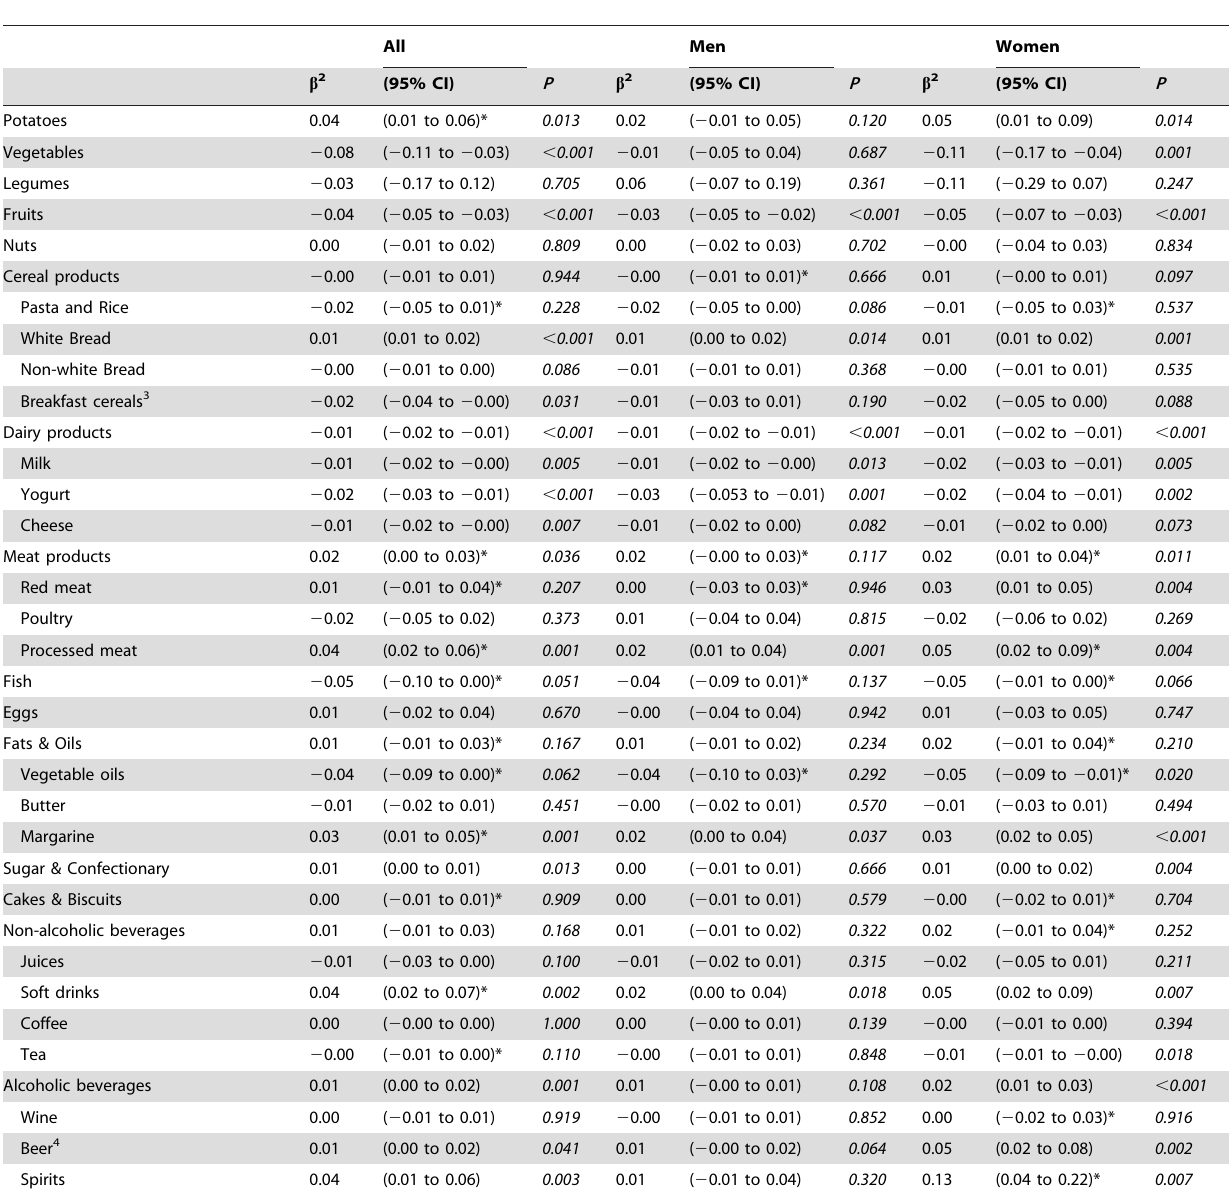
Table 2 . Estimated association between food groups consumption 1 and annual change in ‘‘waist circumference for a given body mass index ( D WC BMI ,